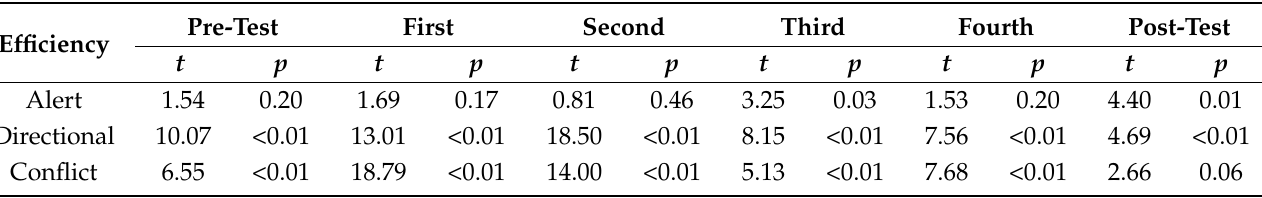
Figure 8. Average activation of ( A ) Oxy-Hb and ( B ) Deoxy-Hb for the two AX-CPT groups. Table 2. t -test of ANT effects in the NINT